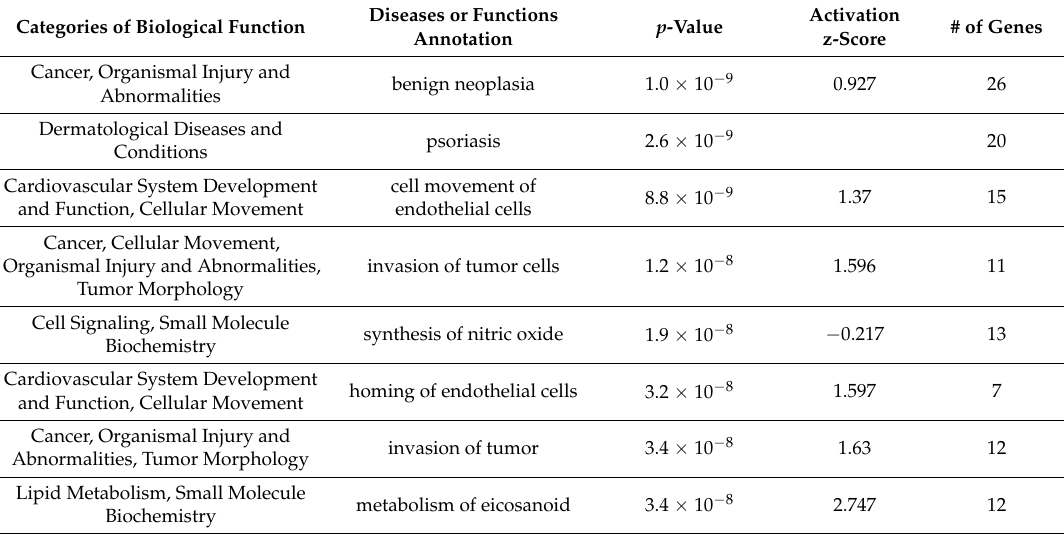
Table 12. Categories of biological functions with diseases or function annotation activated